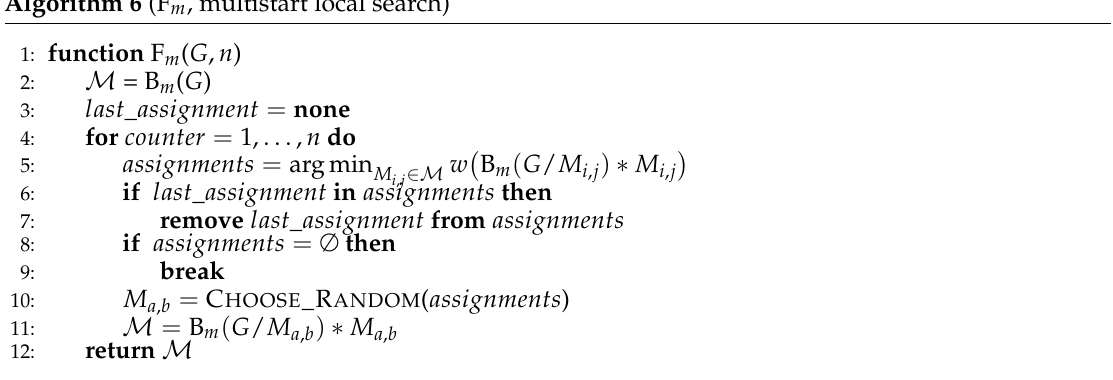
Algorithm 6 (F m , multistart local